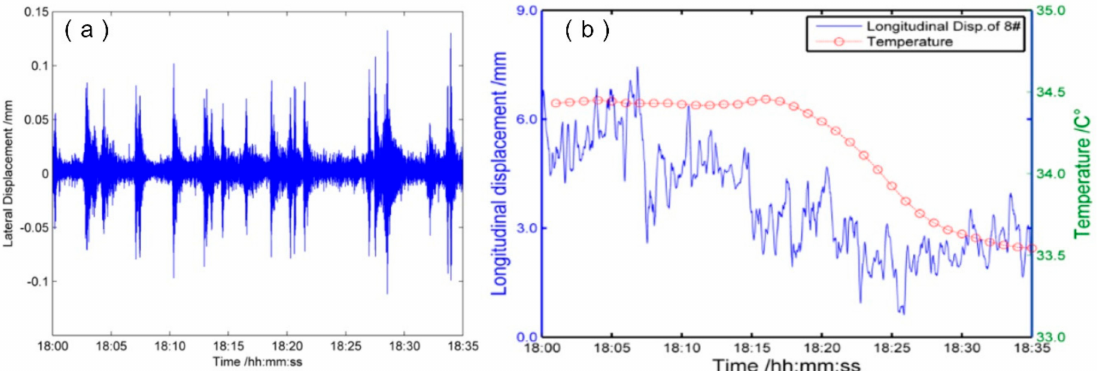
Figure 8. Time series of the horizontal displacements. ( a ) Lateral displacement in the middle of the 192-m span; ( b ) longitudinal displacement and temperature at pier #8 from the existing structure health monitoring (SHM)